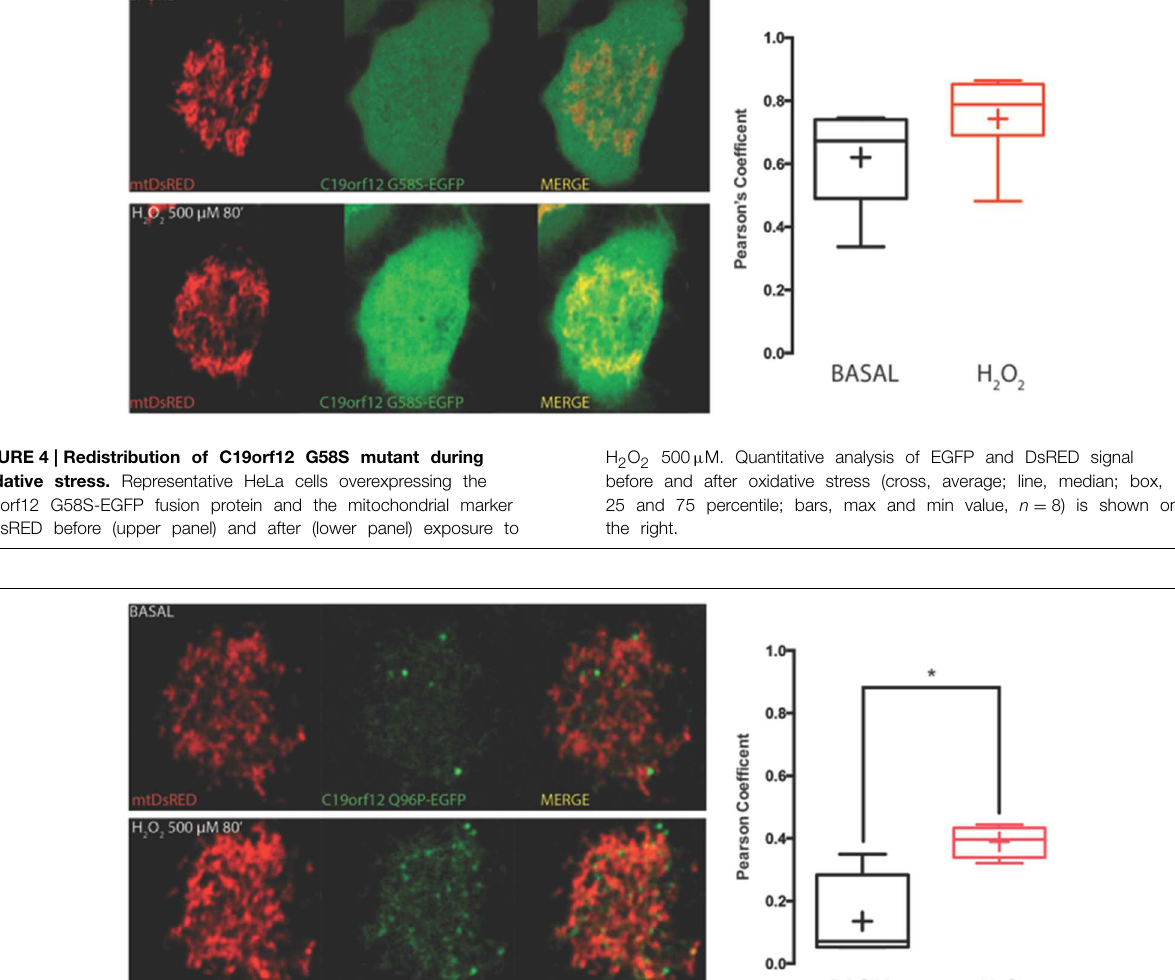
FIGURE 5 | Redistribution of C19orf12 Q96P mutant during oxidative stress. Representative HeLa cells overexpressing the C19orf12 Q96P-EGFP fusion protein and the mitochondrial marker mtDsRED before (upper panel) and after (lower panel) exposure to